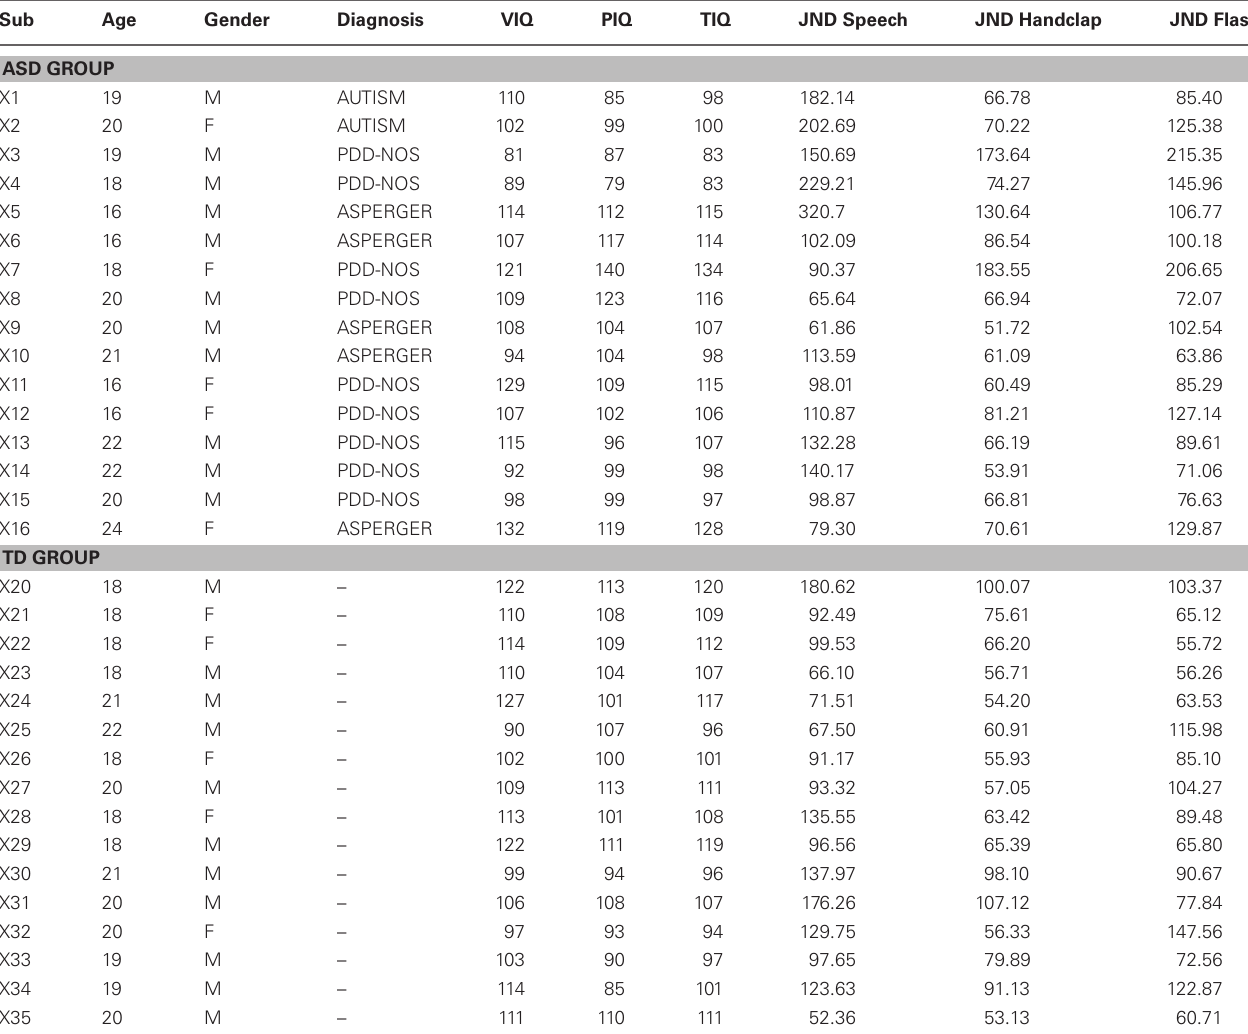
Table 1 | Individual demographics and Just Noticeable Difference (JND) in ms per